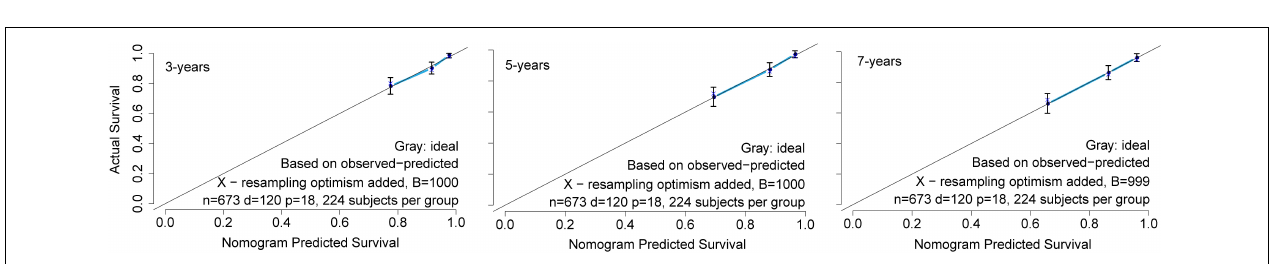
FIGURE 3 | The calibration curve for nomogram. The calibration curve for predicting patient survival at 3, 5, and 7 years in the primary cohort. The nomogram-predicted probability of overall survival is plotted on the x -axis; the actual overall survival is plotted on the y -axis.